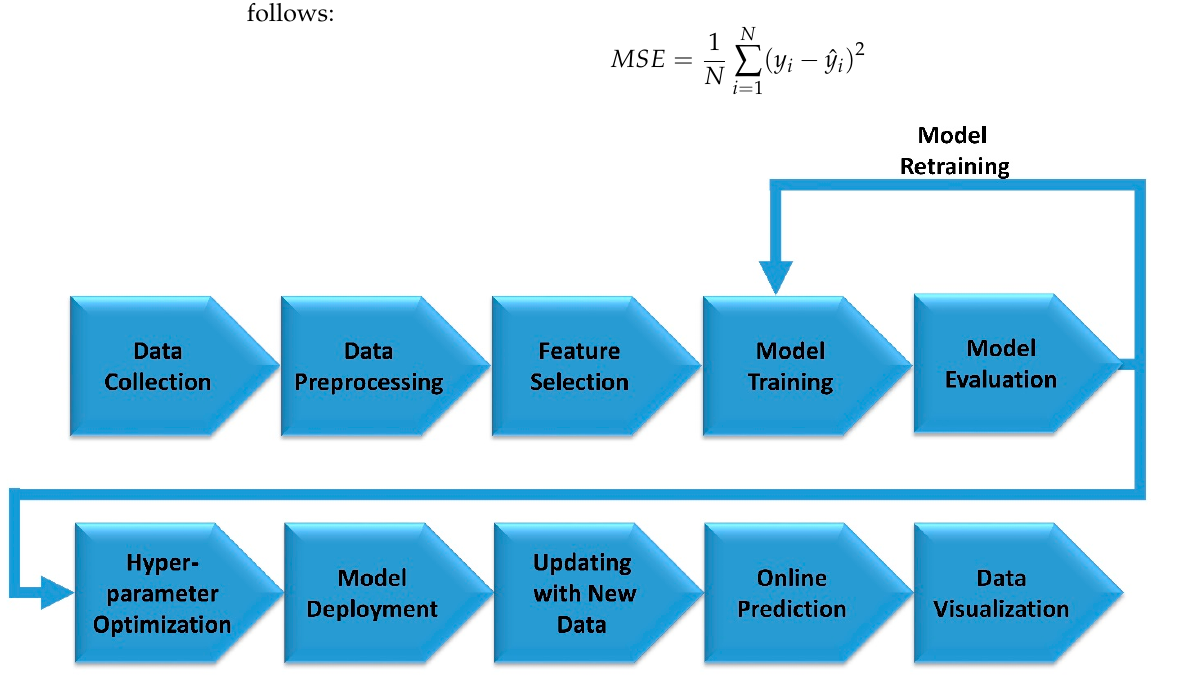
Figure 5. Framework of load forecast